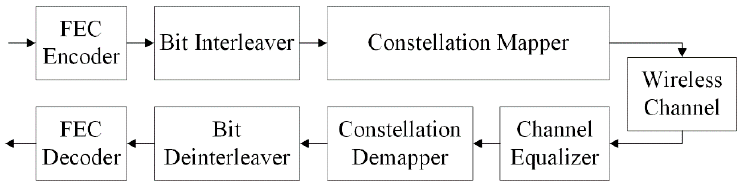
Figure 1. 2D-256NUC and 1D-1024NUC designed for different CRs in ATSC 3.0. ( a ) 2D-256NUC